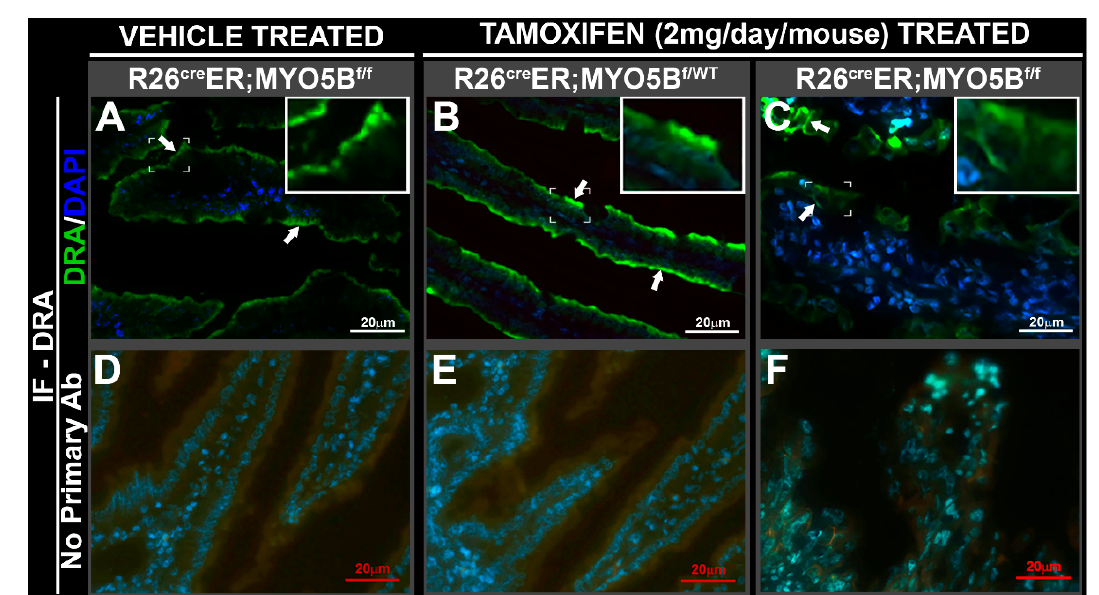
Figure 7. DRA is redistributed to the basolateral membranes in villus enterocytes of cMYO5BKO jejunum. Immunofluorescence localization of DRA in jejunum villus sections from vehicle-treated R26 Cre ER;MYO5B f/f , or tamoxifen (2 mg/day/mouse)-treated R26 Cre ER;MYO5B f/wt and R26 Cre ER;MYO5B f/f mice at day 5. Cryostat jejunum sections were immunolabeled for DRA (green; arrows), and DAPI (blue). ( A ) Vehicle-treated R26 Cre ER;MYO5B f/f (Homozygous), and tamoxifen-treated ( B ) R26 Cre ER;MYO5B f/wt (Heterozygous), or ( C ) R26 Cre ER;MYO5B f/f (Homozygous) mouse jejunum. ( D – F ) Negative control staining of ( A – C ), respectively, stained with secondary antibody only. The normal apical brush border localization of DRA (arrows) observed in vehicle-treated homozygous, or tamoxifen-treated heterozygous mouse jejunum, is redistributed basolaterally in the tamoxifen-treated homozygous mouse jejunum. Brackets circumscribe the areas inserted under higher magnification. Scale bars: 20 µm.